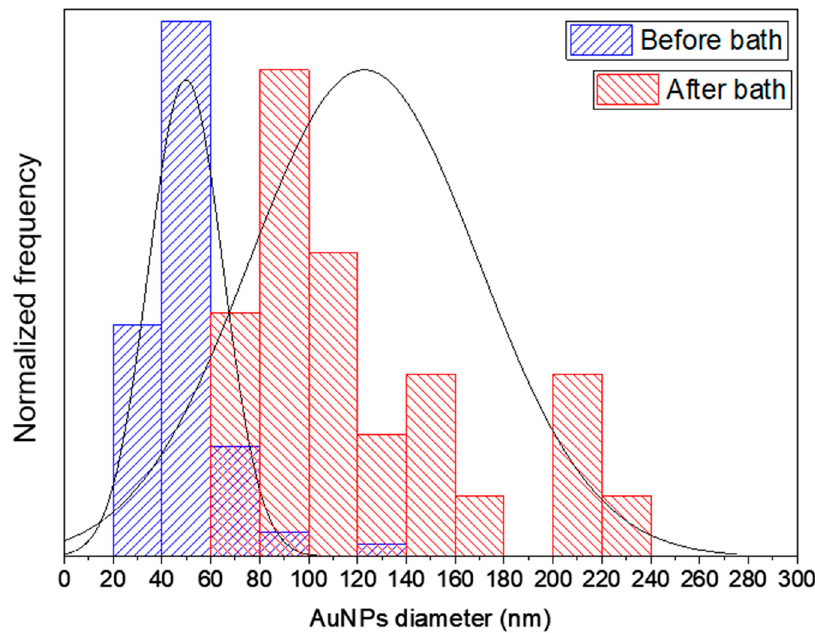
Figure 11. AuNPs size distribution after TPA–DLW and immersion in deionized water (blue, N = 75) and after immersion in a 10 − 2 M HAuCl 4 bath for 30 min (red, N = 27). Gaussian distribution, before and after the bath, evidence the growth of the AuNSs. Quantitative analysis of the AuNPs’ sizes shows that they range from 50 ± 11 nm to 123 ± 35